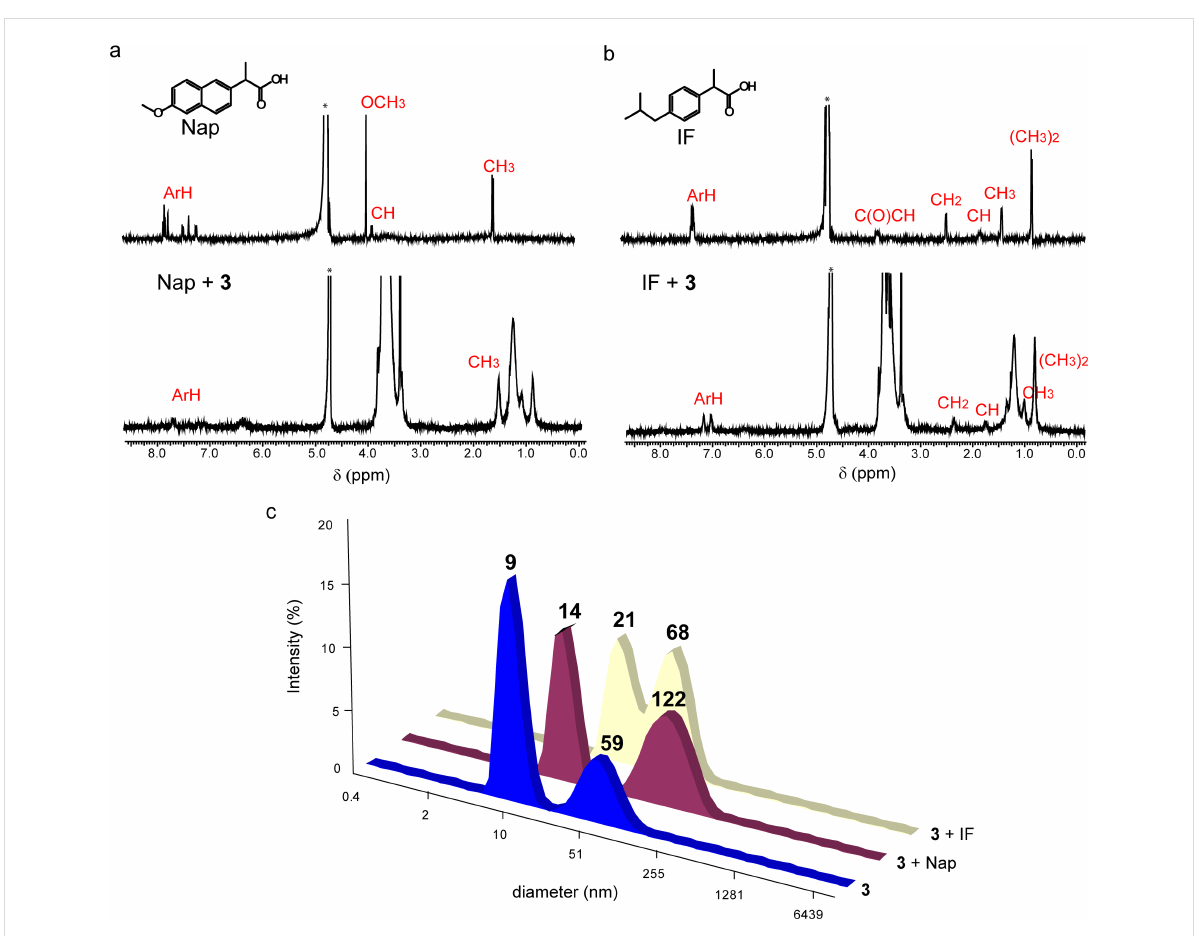
Figure 6: (a) 1 H NMR spectra of Nap and 3 + Nap solutions in D 2 O; (b) 1 H NMR spectra of IF and 3 + IF solutions in D 2 O; (c) intensity-averaged par- ticle size distribution of aqueous solutions of 3 in the absence and the presence of Nap and IF (solubilization method, c 3 = 10 mg/mL).